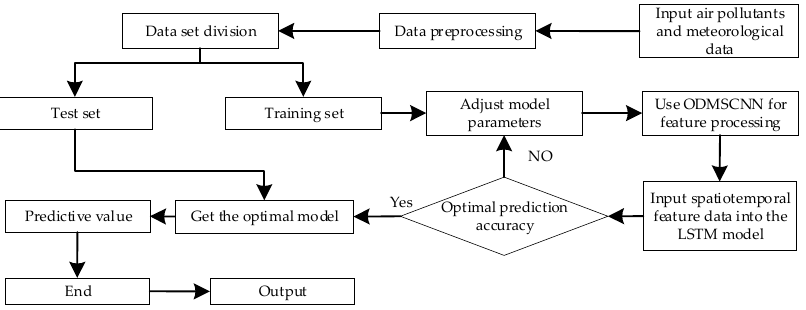
Figure 6. Flow chart of air pollutant concentration prediction model.